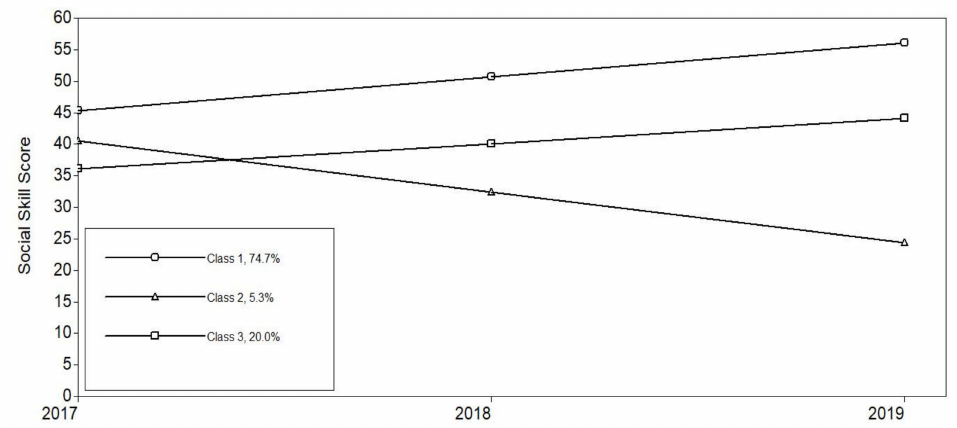
Figure 1. Class trajectories of social skills